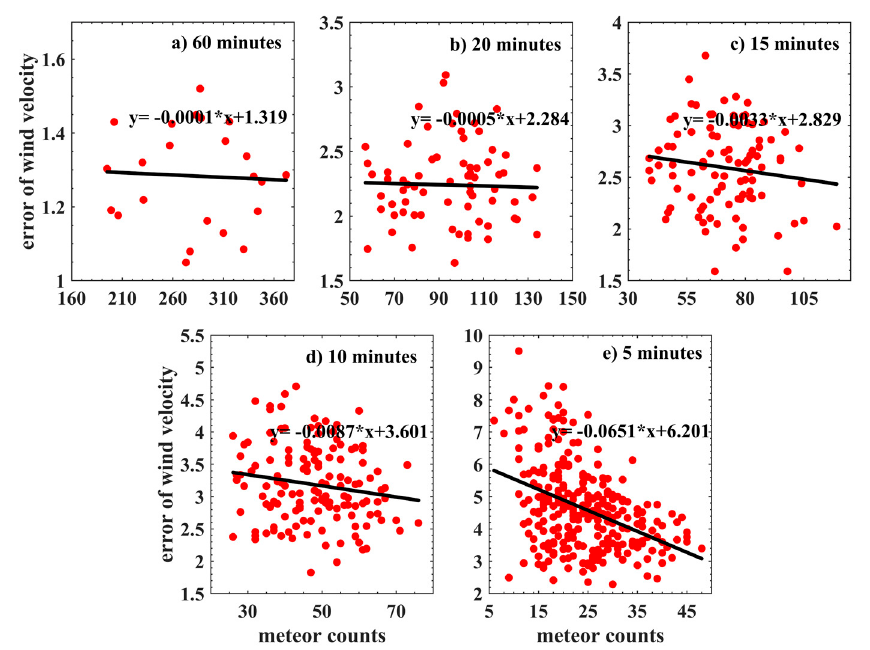
Figure 3. Variation of error (red dots) of zonal winds retrieved by the least square fit with meteor counts in each height/time bin under different temporal resolutions on 23 September 2013. The slashed black line in Figure 3a − e denotes a regression model of the wind error as a function of the meteor counts obtained by the least square method, and the fitting Equations are remarked on the right of the black lines.